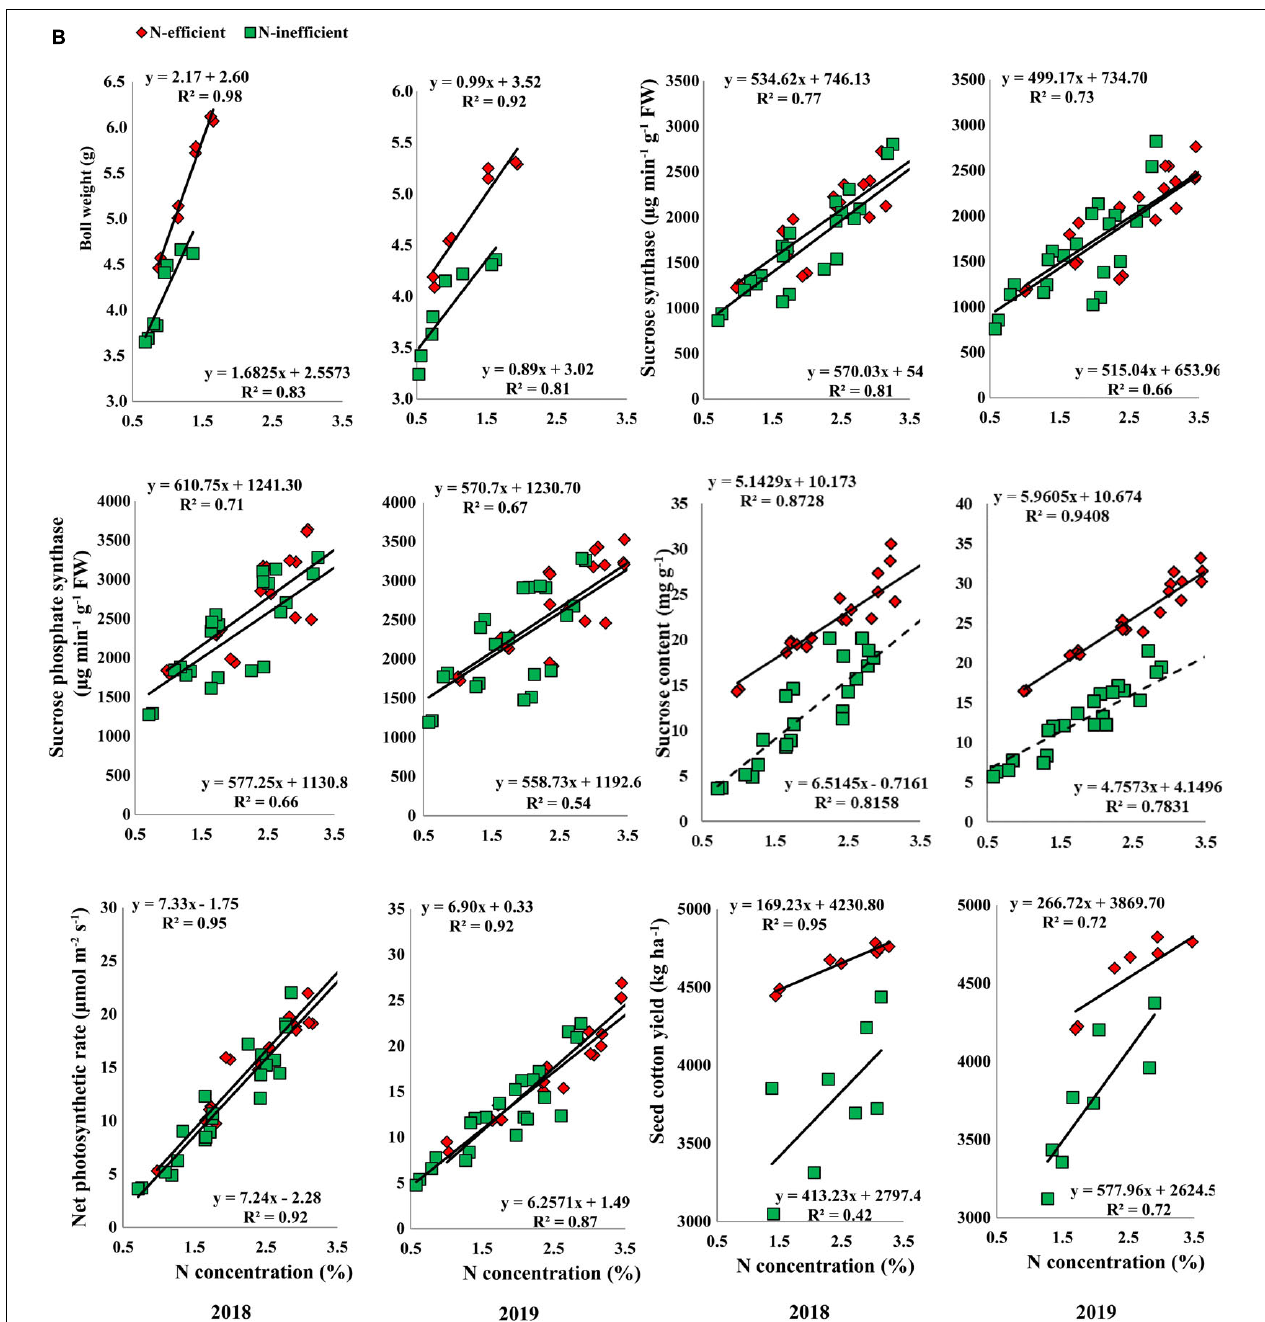
FIGURE 9 | (A) Relationships of subtending leaf N concentration (%) with nitrate reductase ( µ g g − 1 FW h − 1 ), glutamine synthetase activity ( µ mol g − 1 FW h − 1 ), glutamate synthase (U mg − 1 protein), and glutamate dehydrogenase activity (U mg − 1 protein), glutamate-pyruvic transaminase activity (nmol min − 1 mL − 1 ), glutamate oxaloacetic transaminase activity (nmol min − 1 mL − 1 ) of N-efficient (CCRI-69), and N-inefficient (XLZ-30) cotton genotypes under field condition in 2018 and 2019. (B) Relationships of subtending leaf N concentration (%) with boll weight (g), sucrose synthase ( µ g min − 1 g − 1 FW), sucrose phosphate synthase ( µ g min − 1 g − 1 FW), sucrose content (mg g − 1 FW), net photosynthetic rate ( µ mol m − 2 s − 1 ), and seed cotton yield (kg ha − 1 ) of N-efficient (CCRI-69) and N-inefficient (XLZ-30) cotton genotypes under field condition in 2018 and